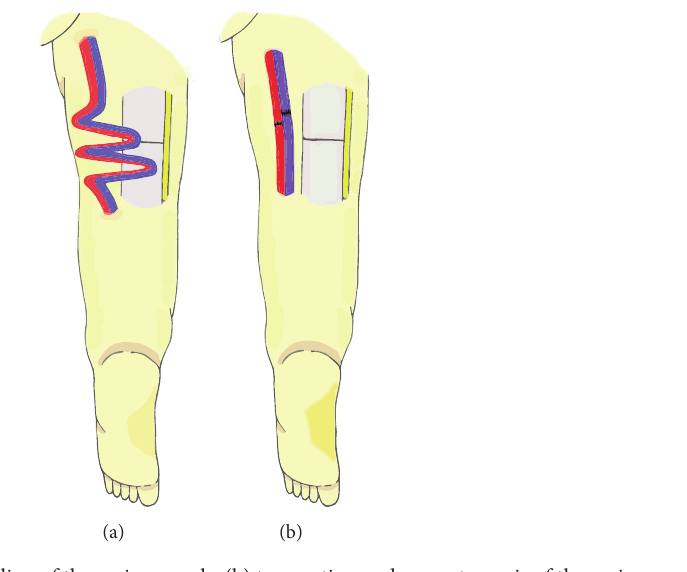
Figure 1: (a) Preservation and coiling of the major vessels, (b) transection and reanastomosis of the major vessels.